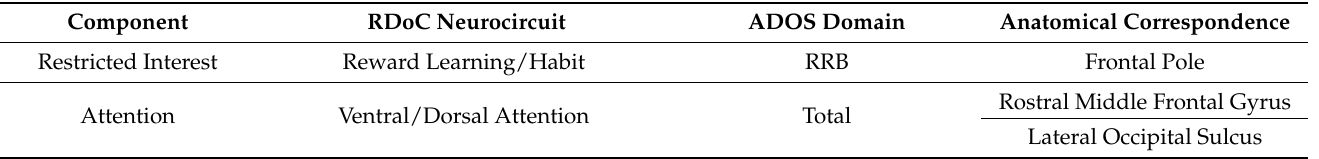
Table 6. The brain regions linked to RDoC Neural Circuits, Behavioral/Cognitive Domains of the ADOS, and ASD Structural